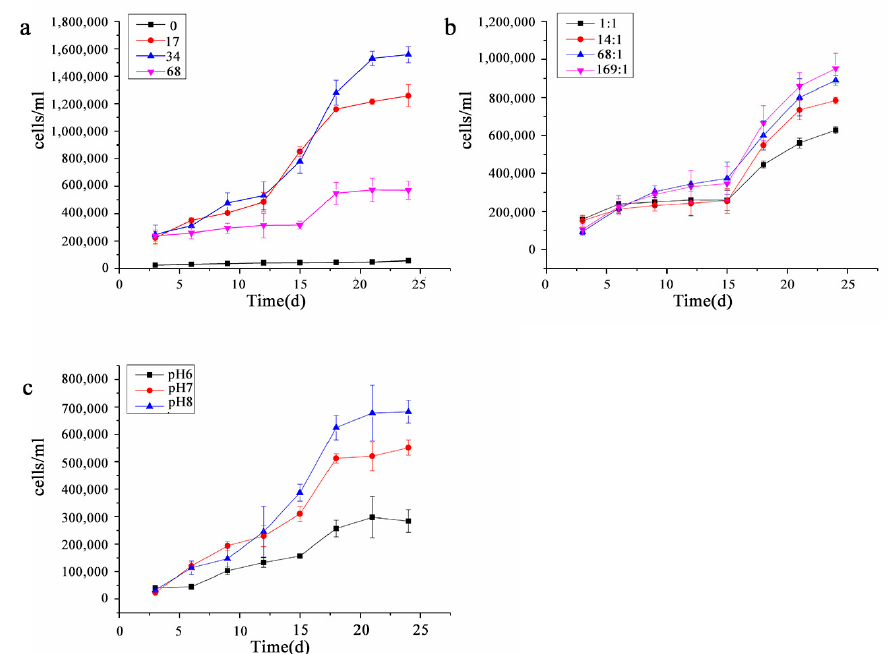
Figure 2. Growth curves of P. purpureum under different environmental factors. Data were expressed as mean ± standard error. ( a ). The growth curves of P. purpureum at different salinities. ( b ). The growth curves of P. purpureum at different nitrogen to phosphorus ratios. ( c ). The growth curves of P. purpureum at different pH conditions.